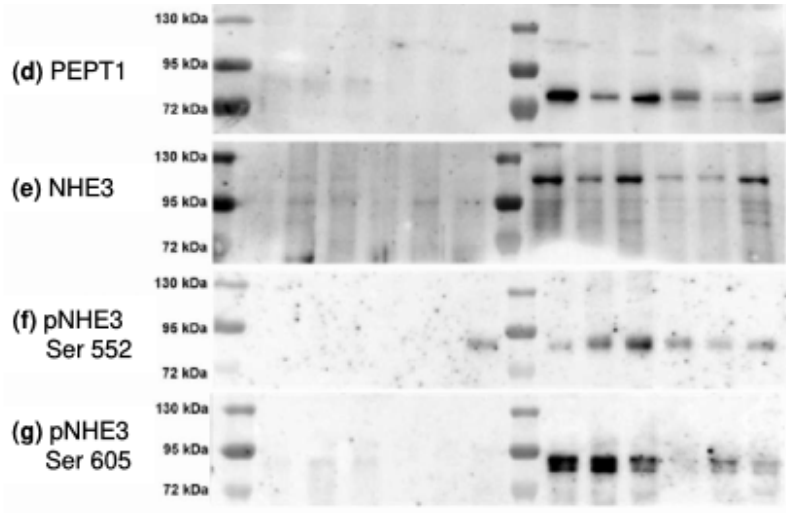
Figure 8. Representative Western blots of ( a ) the non-DRM marker Na + /K + -ATPase ( b ) the DRM marker flotillin-1 (Flot-1) and the transport proteins SGLT1 ( c ), PEPT1 ( d ), NHE3 ( e ) and phosphorylated NHE3 at Serin522 ( f ) and Serin605 ( g ) in non-DRM and DRM fractions prepared from jejunal or ileal tissues after treatment with resveratrol (10 µ M or 300 µ M, 30 min).